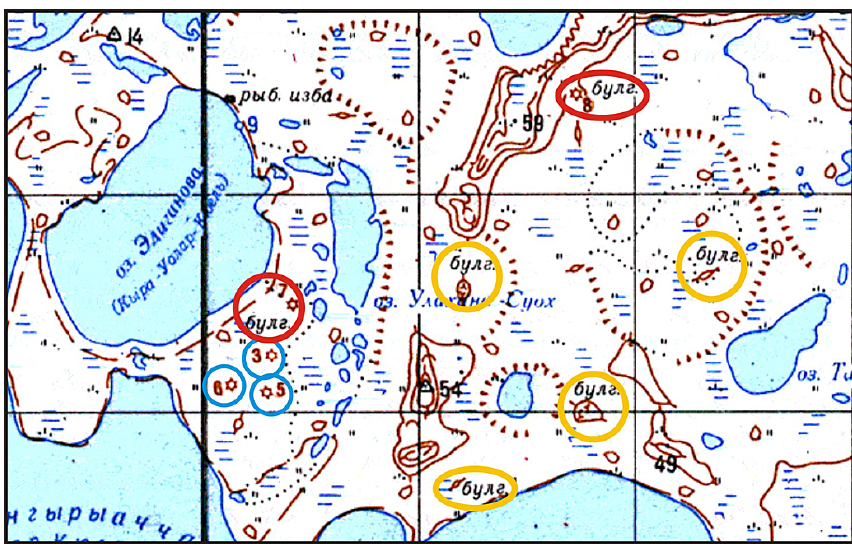
Fig. 3. Subset of topographic map 1:200000 from the Indigirka lowland with examples of pingos (grid spacing is 4km). Red circles – pingos are marked with red star and the label “ bulg. ” for bulgunnyakh , height given in m; blue circles – pingos are marked with red star but not specifically labelled, height given in m; yellow circles – pingos are marked with contour lines and the label “ bulg. ”.